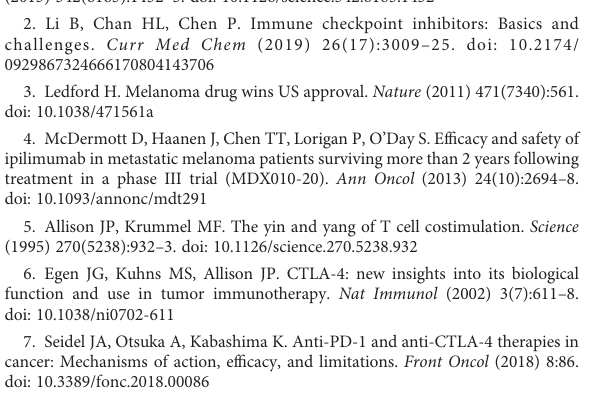
SUPPLEMENTARY FIGURE 5 Representative fl ow cytometry graphs of memory T cells in the blood. Memory Tcellspopulations 21dayspost tumorrechallenge werepro fi led. The survivor mice cured by different immunoradiotherapies were rechallenged with 344SQR cells 156 days following their fi nal fraction of radiation. Naïve mice were also challenged with the same number of 344SQR cells and served as